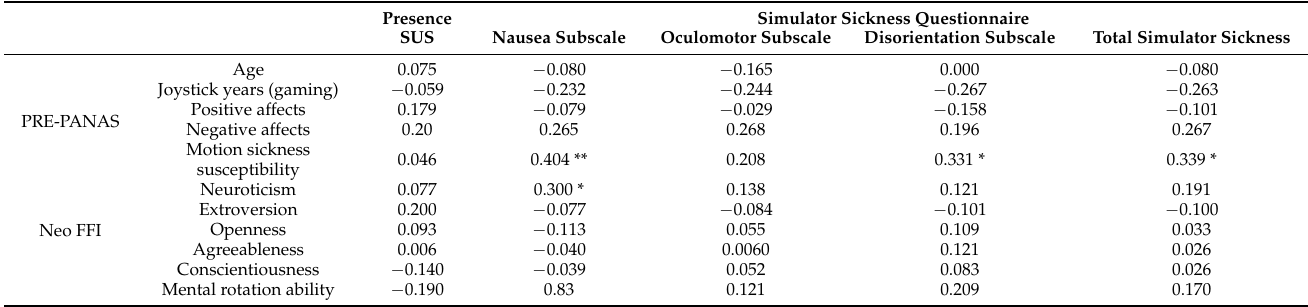
Table 2. Spearman’s correlations between the analyzed individual factors and reported sense of presence and experienced degree of simulator sickness.